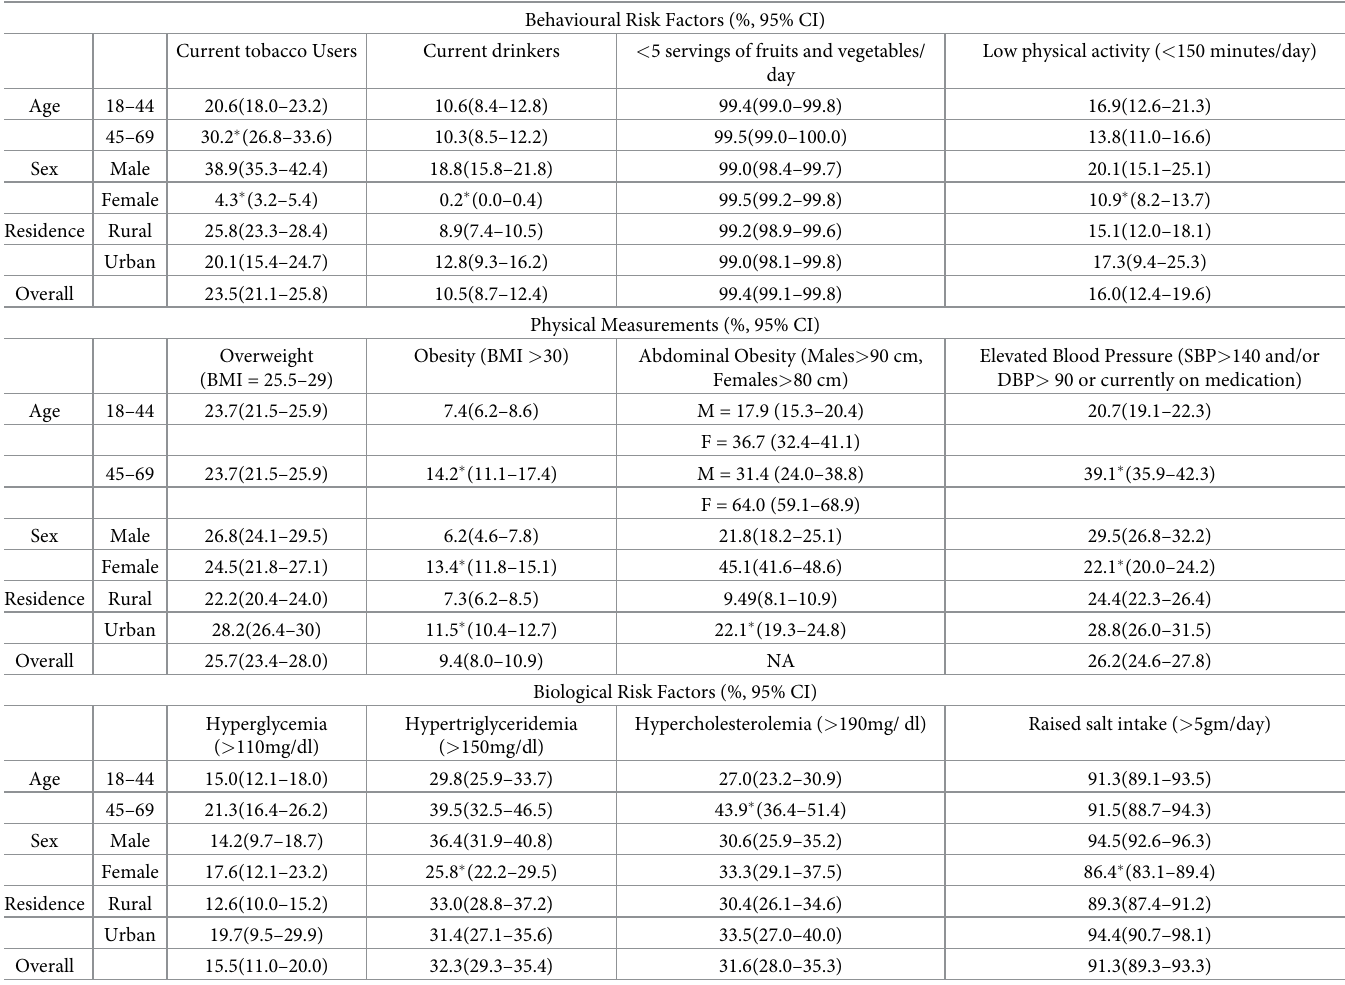
Table 2. Prevalence of various NCD risk factors in Haryana, overall and stratified by age group, gender and residence (Rural/Urban),